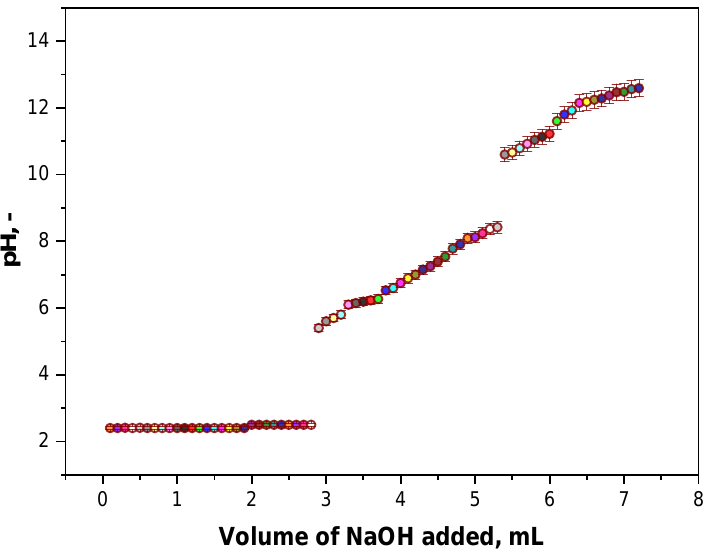
Figure 11. Results of the potentiometric titration of chitosan solution.